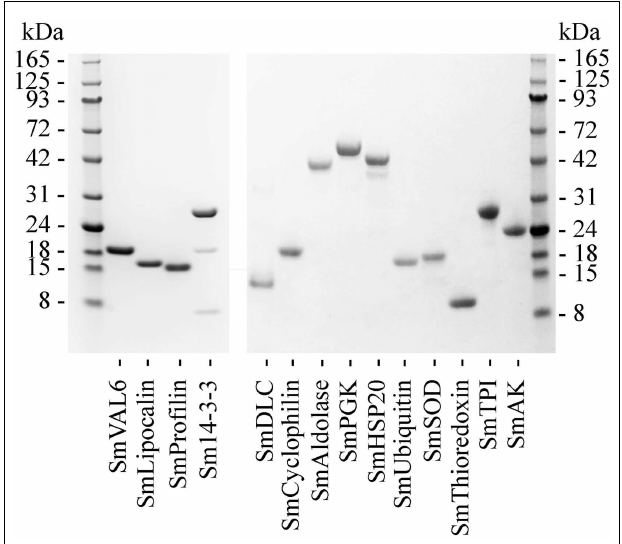
FIGURE 1 | SDS-PAGE of recombinant antigens following expression and purification . Proteins were run on a 4–12% gradient Bis-Tris gel and stained with Coomassie